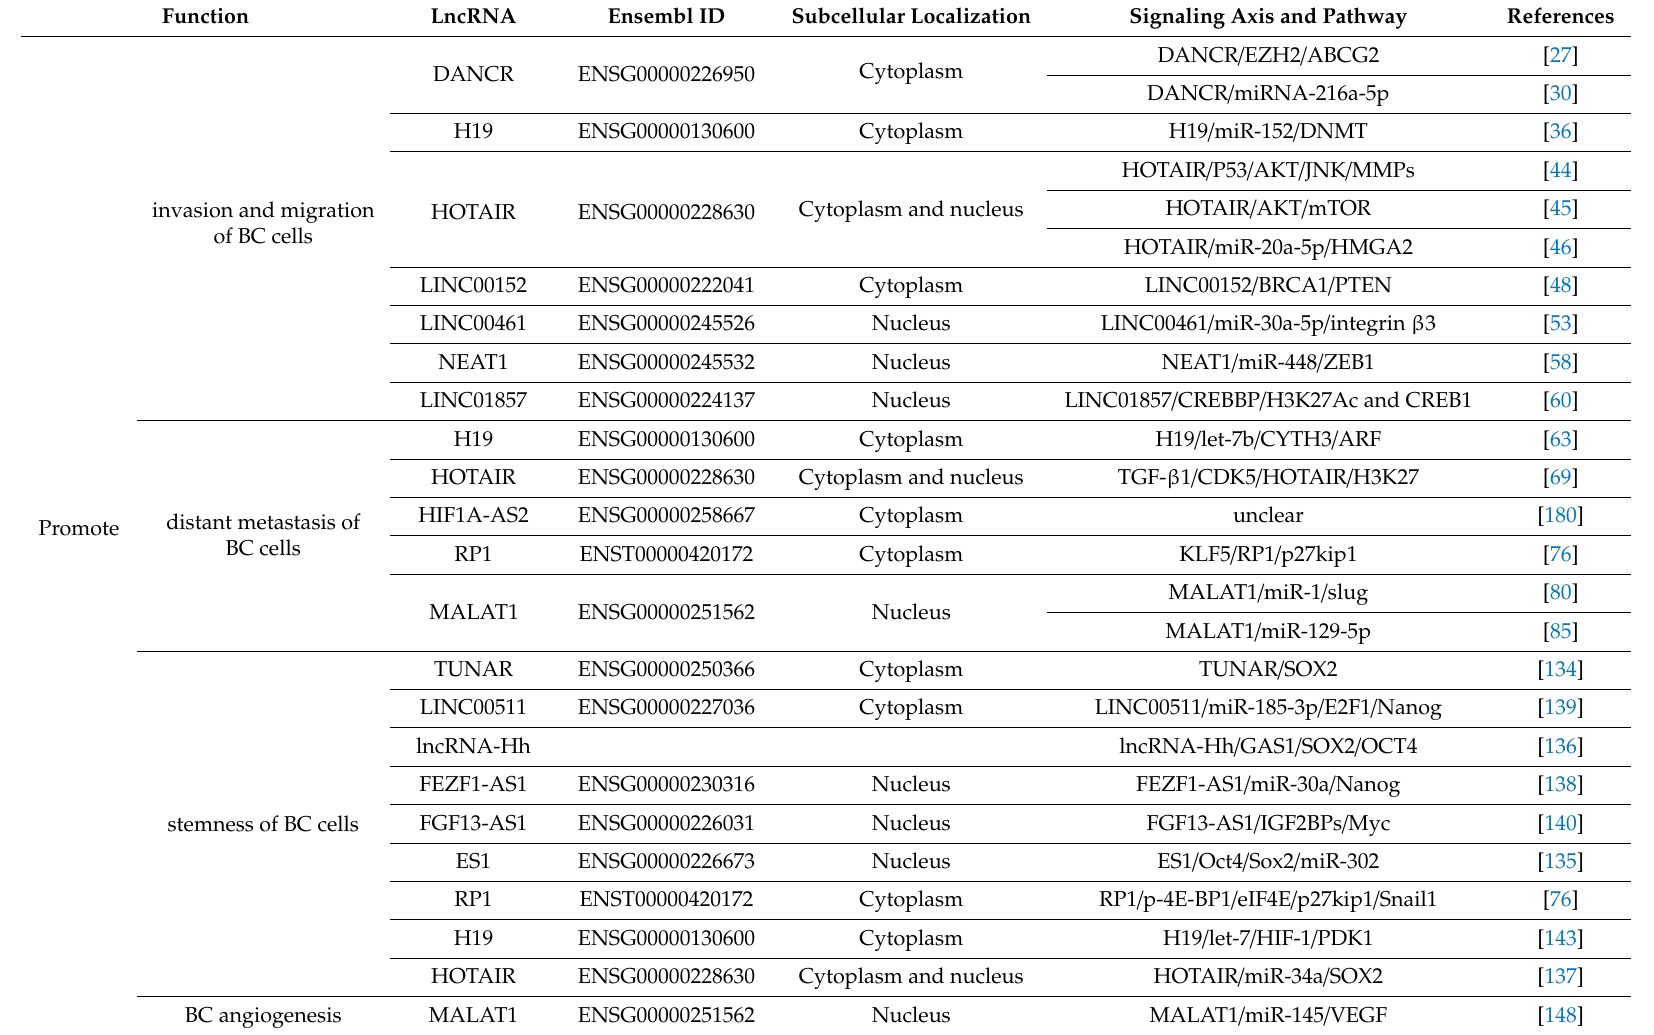
Table 1. Dual e ff ects of lncRNAs in various stage of BC